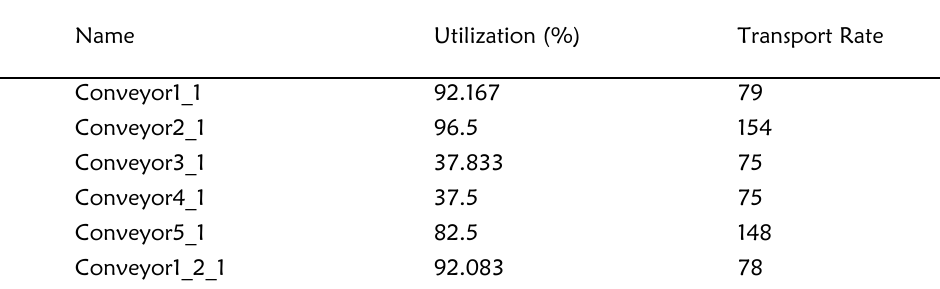
Table 6: Utilization and transport rate for the proposed system (Fig